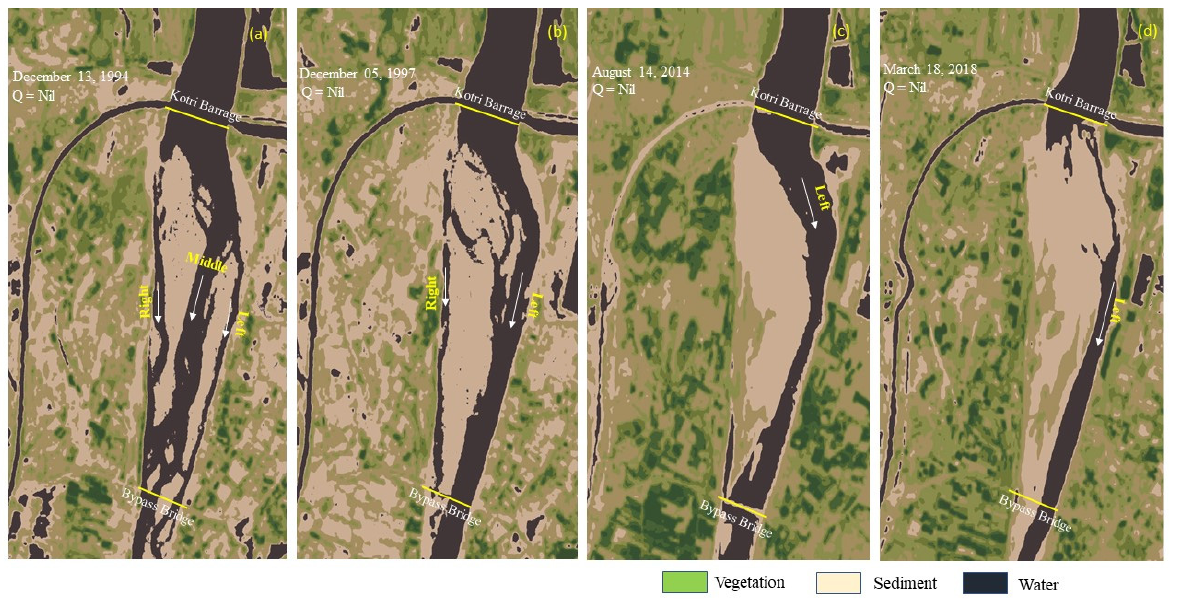
Figure 4. Visual comparisons of Landsat imageries for the study area river-reach. ( a ) TM acquired an image on 13 December 1994, showing three active riverine channels at zero discharge; ( b ) TM acquired an image on 5 December 1997, showing two active riverine channels at zero discharge; ( c ) OLI and TIRS acquired an image on 14 August 2014, resulting in only one active riverine channel at zero discharge; ( d ) OLI and TIRS acquired an image on 18 March 2018, representing only one active riverine channel at zero discharge.